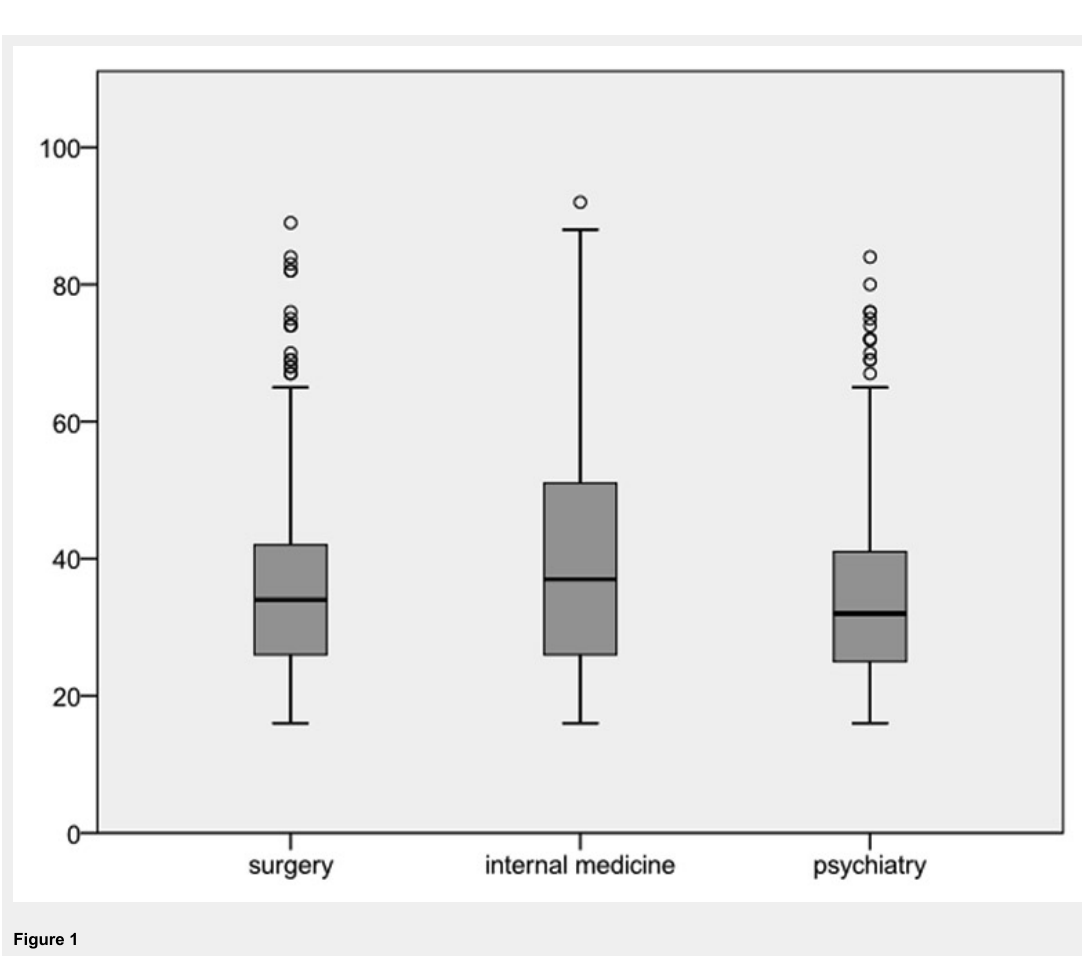
Figure 1 ■Age distribution and reason for presentation (clinical